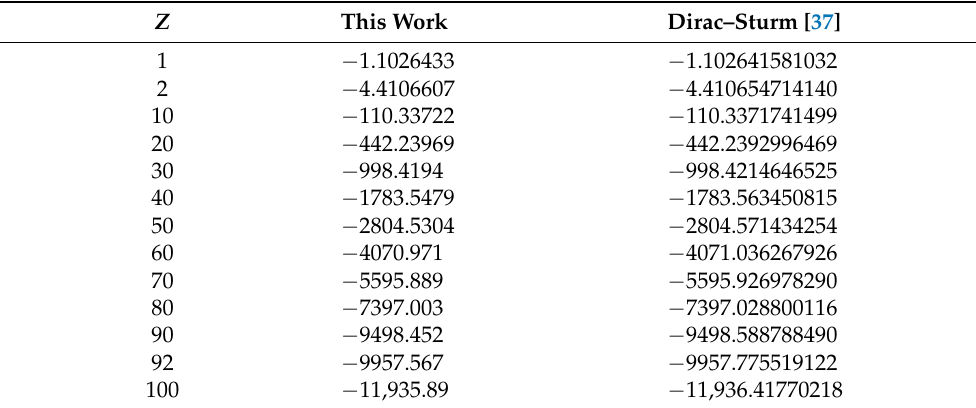
Table 1. Comparison of the ground-state energies (in a.u.) of one-electron quasimolecular systems with Z = 1, . . . ,100 at the internuclear distance D = 2/ Z a.u.